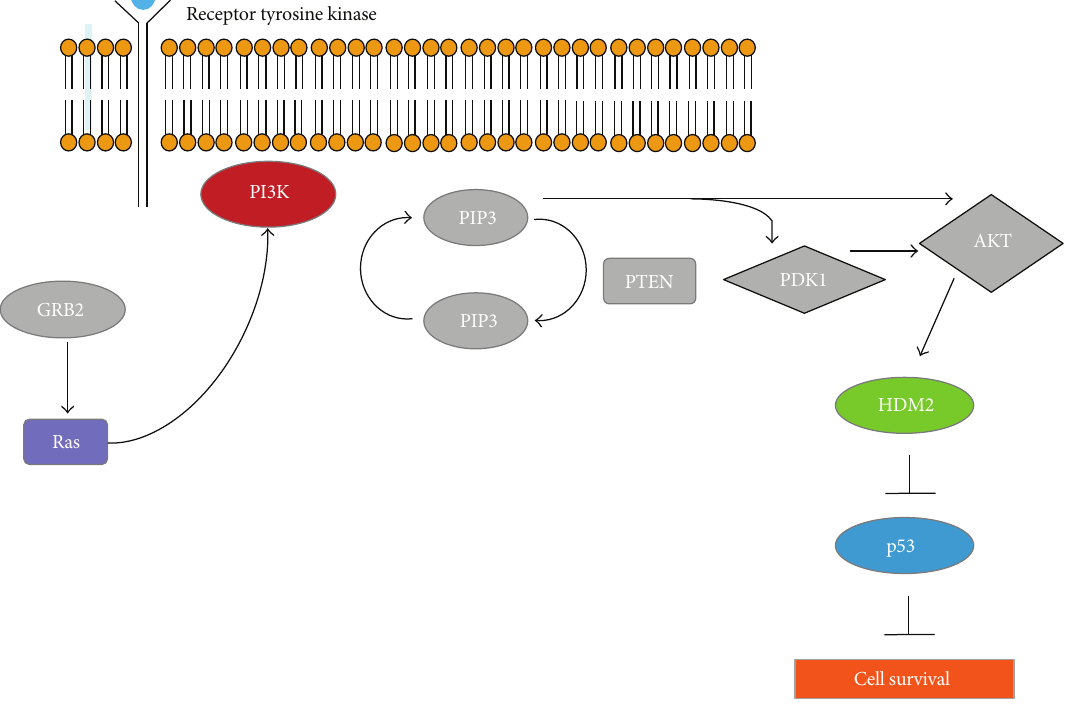
F 2: Signaling mechanism of